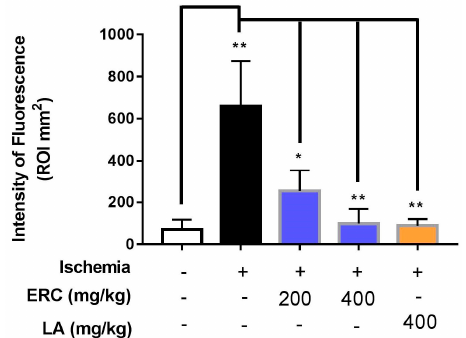
Figure 4. Graphical representation of the intensity of the fluorescence signal generated after induction of ischemia. Animals treated with ERC and LA exhibited a significant reduction in the ischemia-induced signal compared to the untreated group (control). Data are expressed as mean ± SEM ( n = 3), * p -value <0.05, ** p -value <0.01.